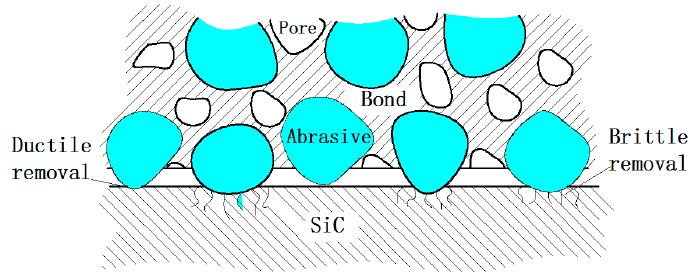
Figure 6. Schematic diagram of fixation abrasive grinding.